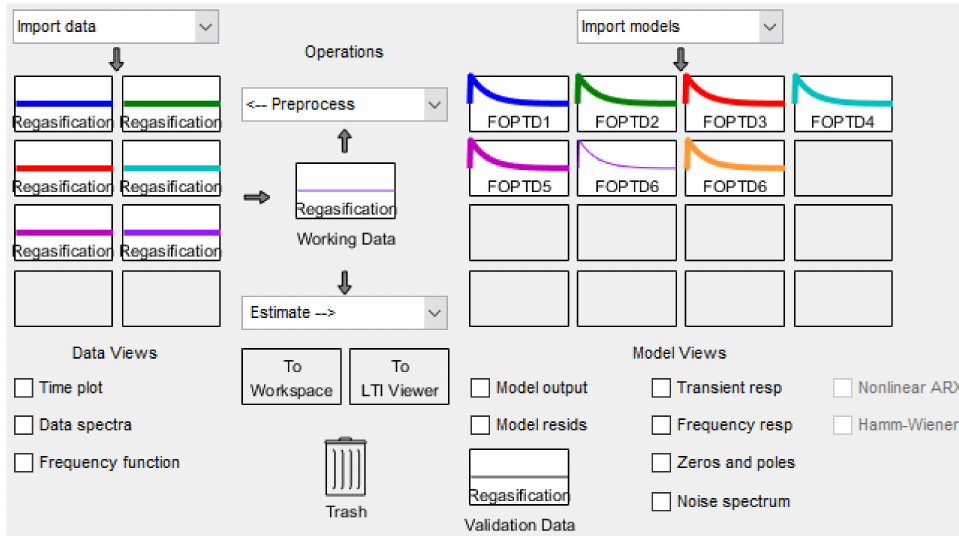
Figure 4. Screen of the system identification toolbox for approximation with an FOPTD model. The FOPTD model of the regasification system is obtained as K = 1.2508, L = 4.1, and T = 30.578 through several iterations in the identification toolbox of MATLAB using unit steps as input and glycol temperature as output. At this time, the sampling time is 0.01 s. The outputs and error when the unit step input is introduced to the original regasification open-loop system and the approximated FOPTD model are shown in Figure 5. The approximated model closely matches the original system.